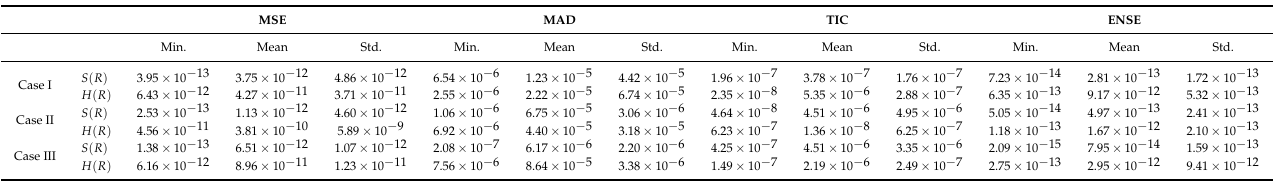
Table 4. Stability analysis on the values of performance function and performance indicators in terms of minimum, mean and standard deviations for different cases of scenario-I.